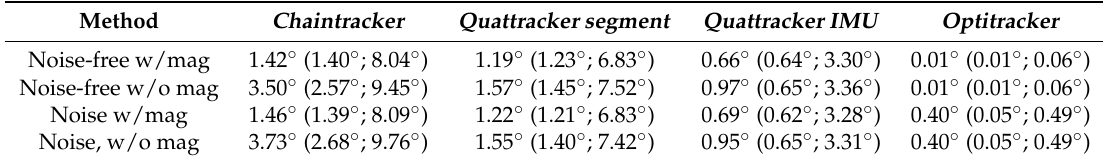
Table 9. Simulation scenario without calibration errors ( sim-fast ): mean (std; max) angular errors over all segments on the two test configurations (w/mag, w/o mag), both on noise-free (perfect) and noisy IMU